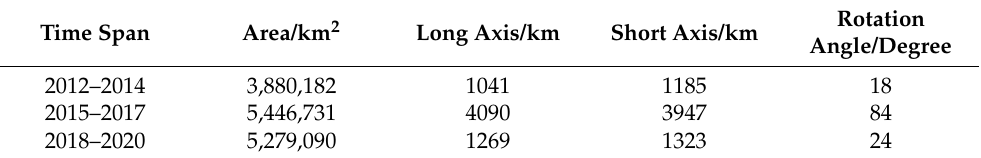
Table 4. Moran’s I index during three time periods.